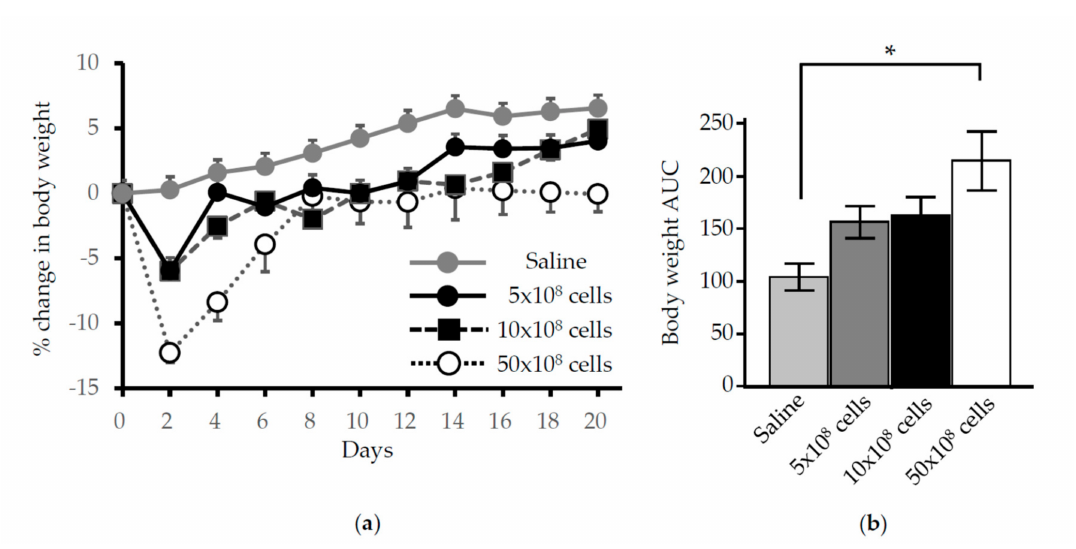
Figure 1. Change in body weight after nasal administration of L. lactis . ( a ) Time course analysis of percent change in body weight in mice treated with 0, 5, 10, or 50 × 10 8 L. lactis cells, showing significant loss of over 12% on day 2 in the group receiving 50 × 10 8 cells. ( b ) The area under the curve (AUC) of the body weight measurements was calculated based on the minimum value for each mouse.